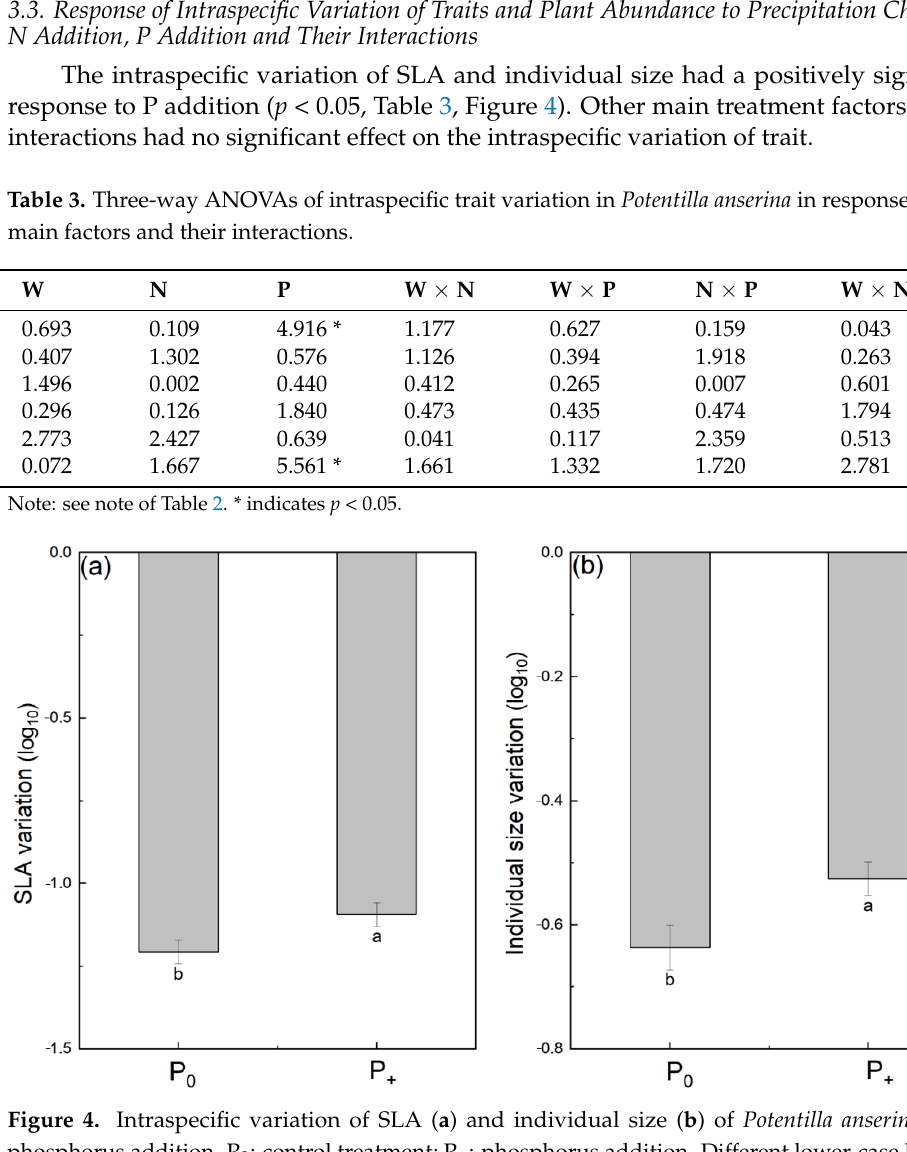
Table 3. Three-way ANOVAs of intraspecific trait variation in Potentilla anserina in response to three main factors and their interactions.